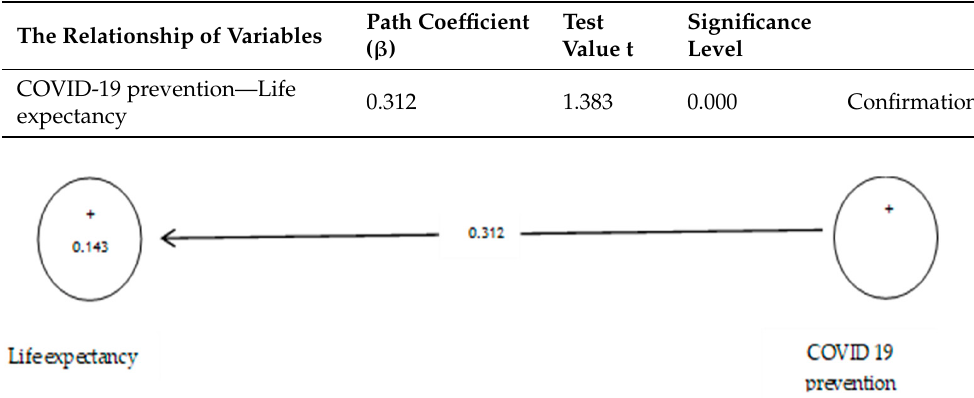
Figure 6. The second sub-hypothesis model includes factor load coefficients.